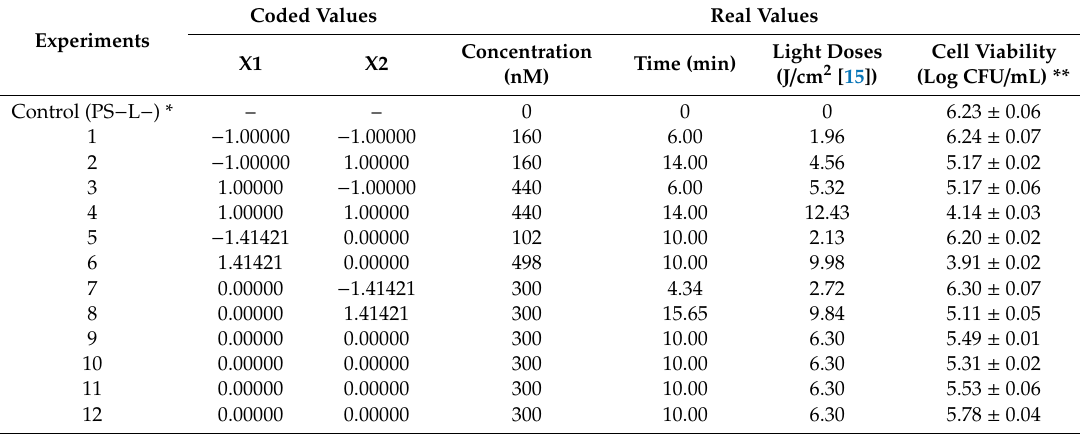
Table 1. Experimental design (coded and real values) used to determine the combined influence of two independent variables (eosin (EOS) concentration and irradiation time) on S. aureus cells viability. The EOS concentration and irradiation time was used to calculate the light dose, according to Gerola et al.